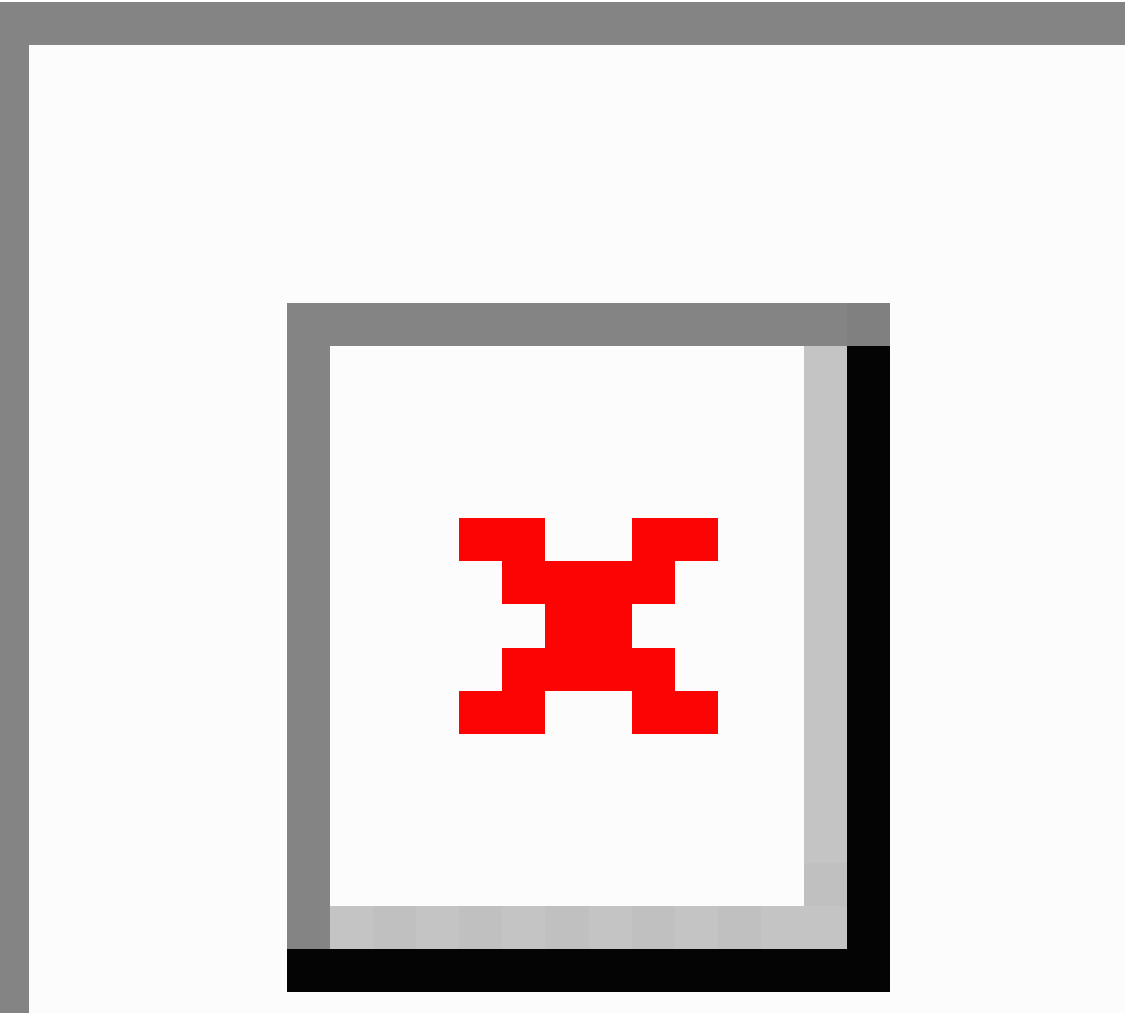
Figure 5. Additional findings and free-text options, including a list of standard incidental findings and free-text options for additional information of incidental findings, notes, and a concluding personal